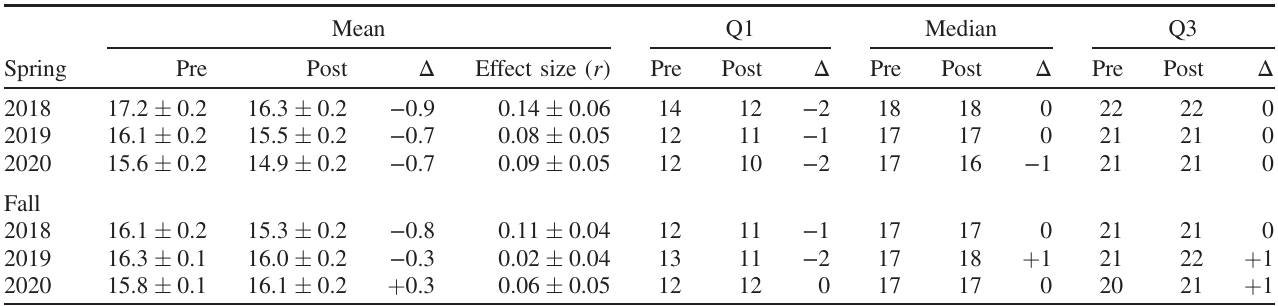
TABLE II. Summary statistics for the distributions shown in Fig. 1 and for the equivalent distributions in 2018. Δ corresponds to the post-test score (Post) minus the pretest score (Pre). Uncertainties on the mean scores are the standard error. The effect size ( r ) and the 95% confidence intervals are calculated using the result of the Wilcoxon signed-rank test [43] using the wilcoxonPairedR function [31] and is used here because we are comparing matched data from the same student from pretest to post-test.